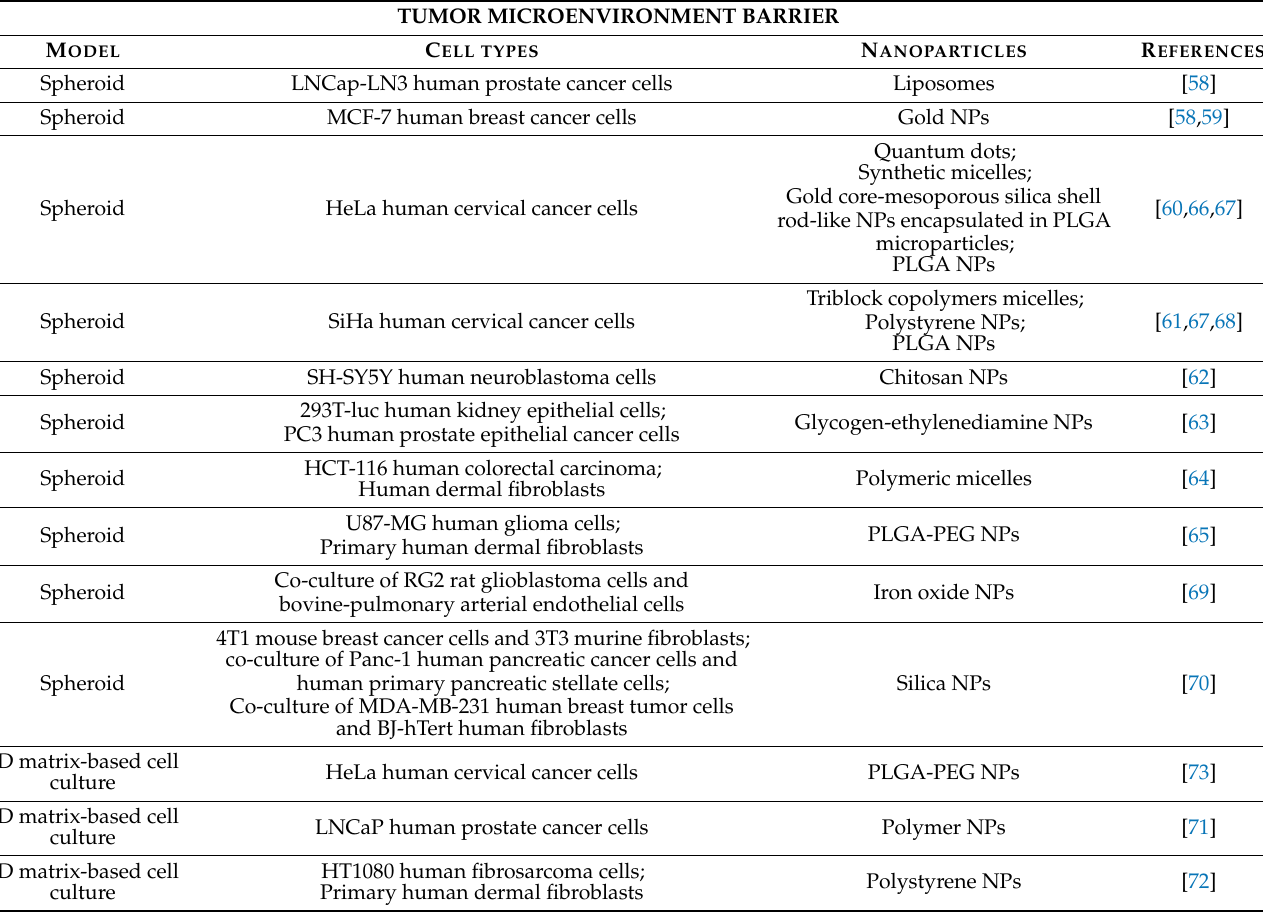
Table 2. Summary of in vitro tumor microenvironment barrier models used for nanomedical studies. TUMOR MICROENVIRONMENT